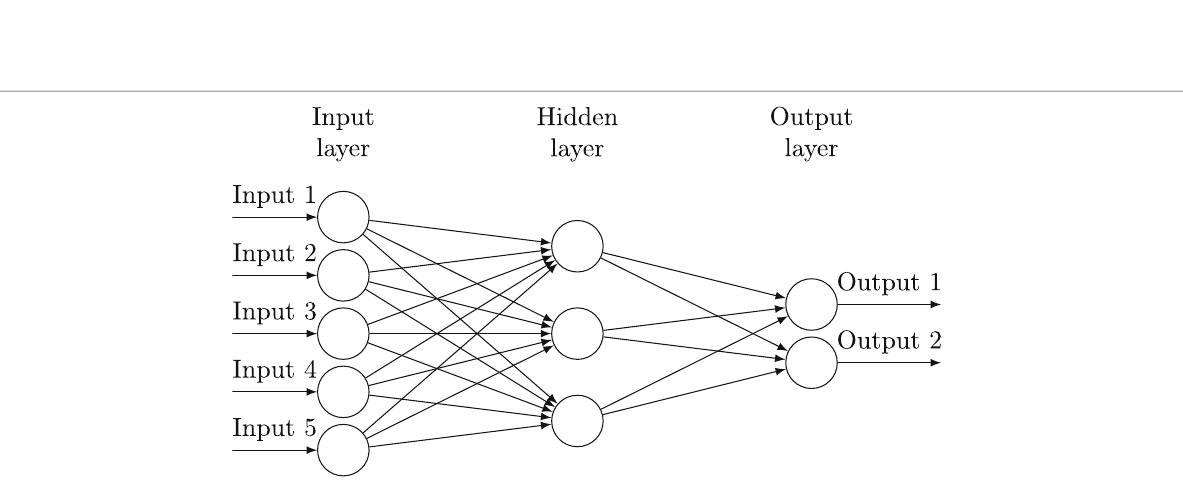
Fig. 3 Basic scheme of a fully connected neural network with five inputs, two outputs, and a single hidden